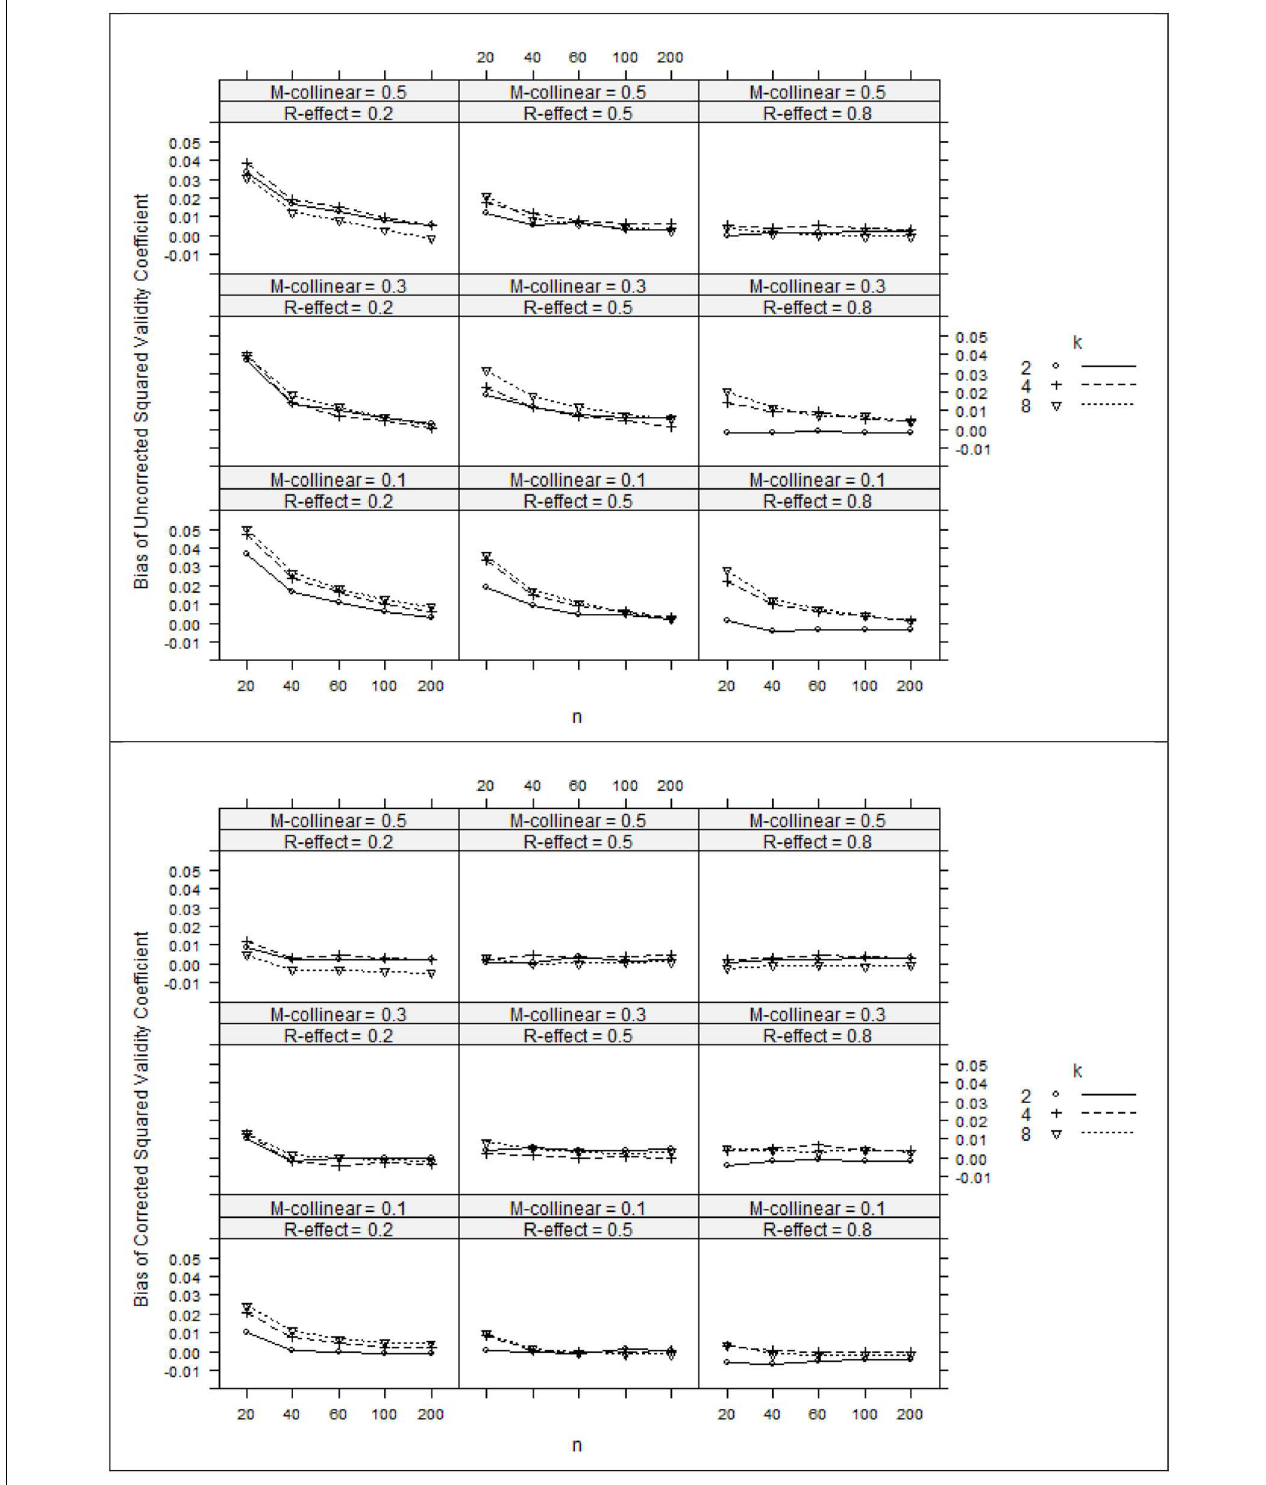
FIGURE 3 | Bias of squared validity coefficients (top panel) and corrected squared validity coefficients (bottom panel). k , number of predictors; n , sample size.